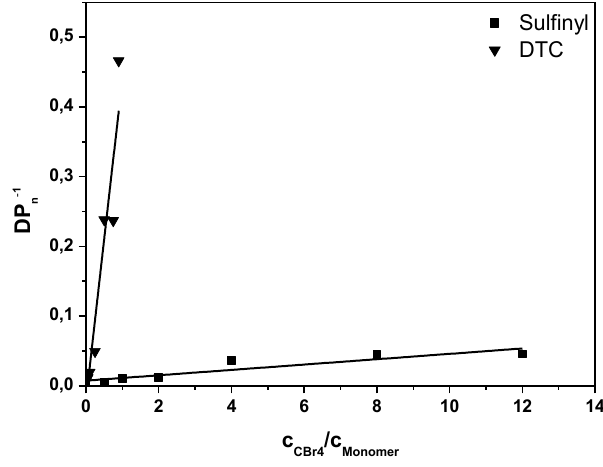
Figure 1 . Inverse of the degree of polymerization as a function of the CTA to premonomer concentration ratio for MDMO-PPV synthesized via the sulfinyl and the DTC route.